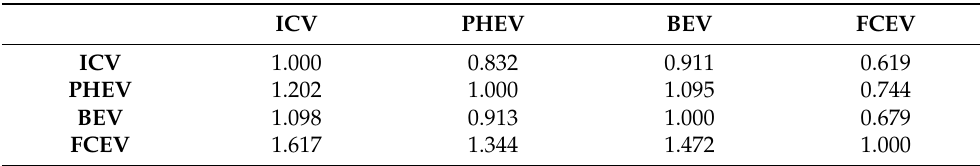
Table 6. Importance ratios between alternatives for the GWP criterion fitted to the preference scale (1–9). ICV PHEV BEV FCEV ICV 1.000 0.276 0.440 0.111 PHEV 2.273